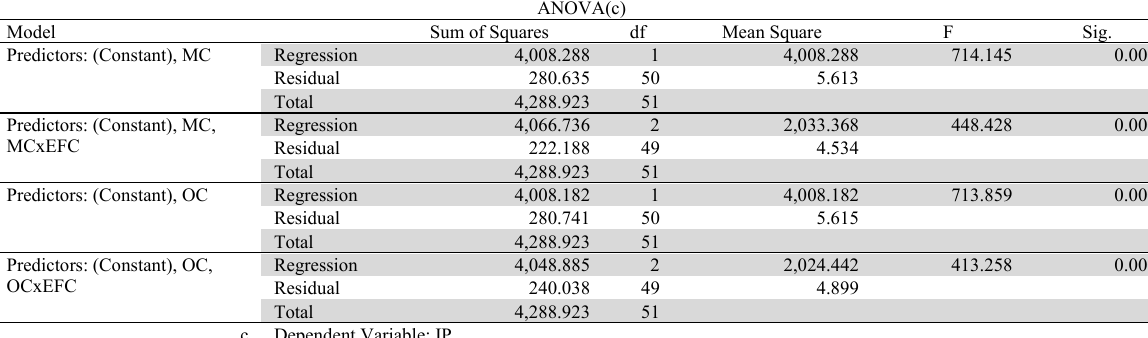
The results of ANOVA test